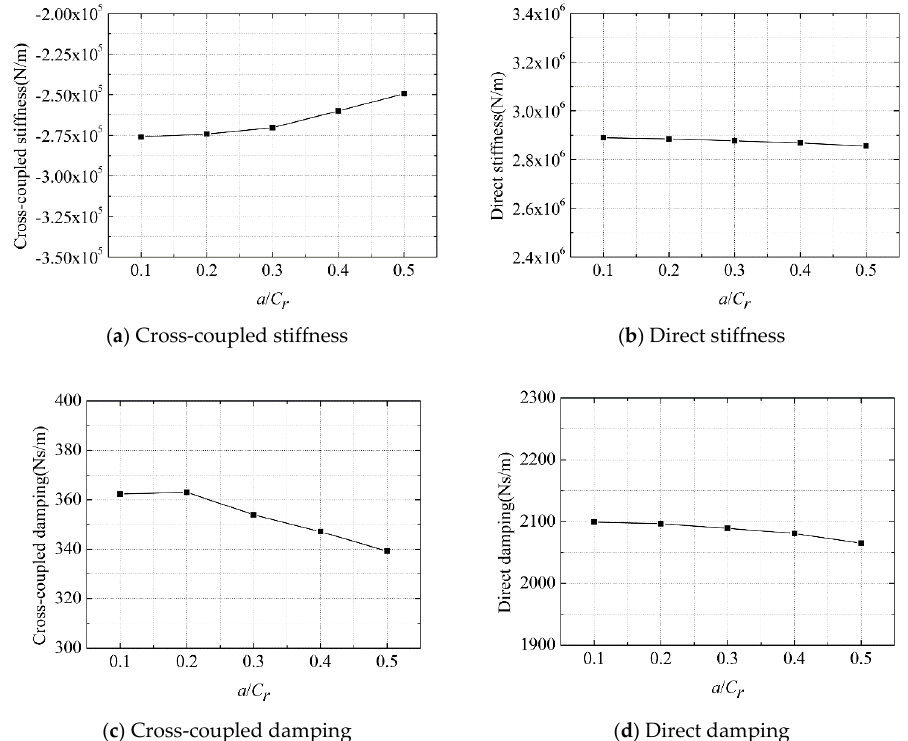
Figure 15. Variations in rotordynamic coefficients with whirl amplitude.